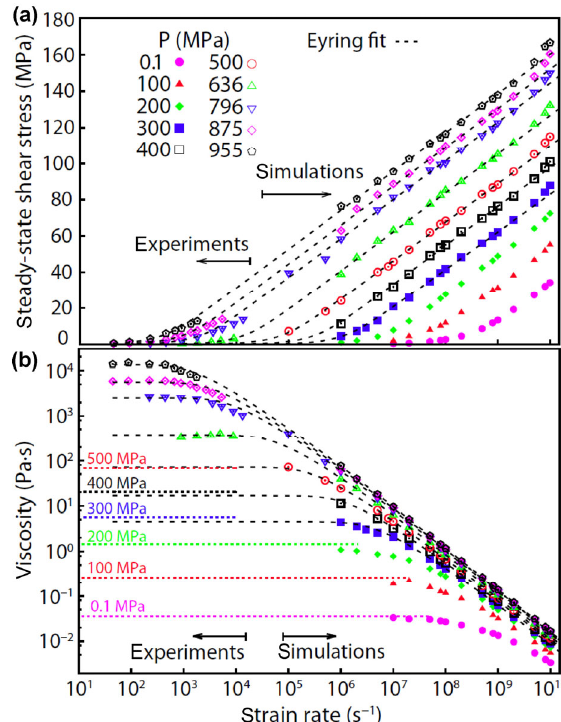
Fig. 7 Friction versus log(sliding speed) for a vulcanised styrene- butadiene copolymer rubbed against polished steel at 40 °C and 0.65 kg normal load. Reproduced with permission from